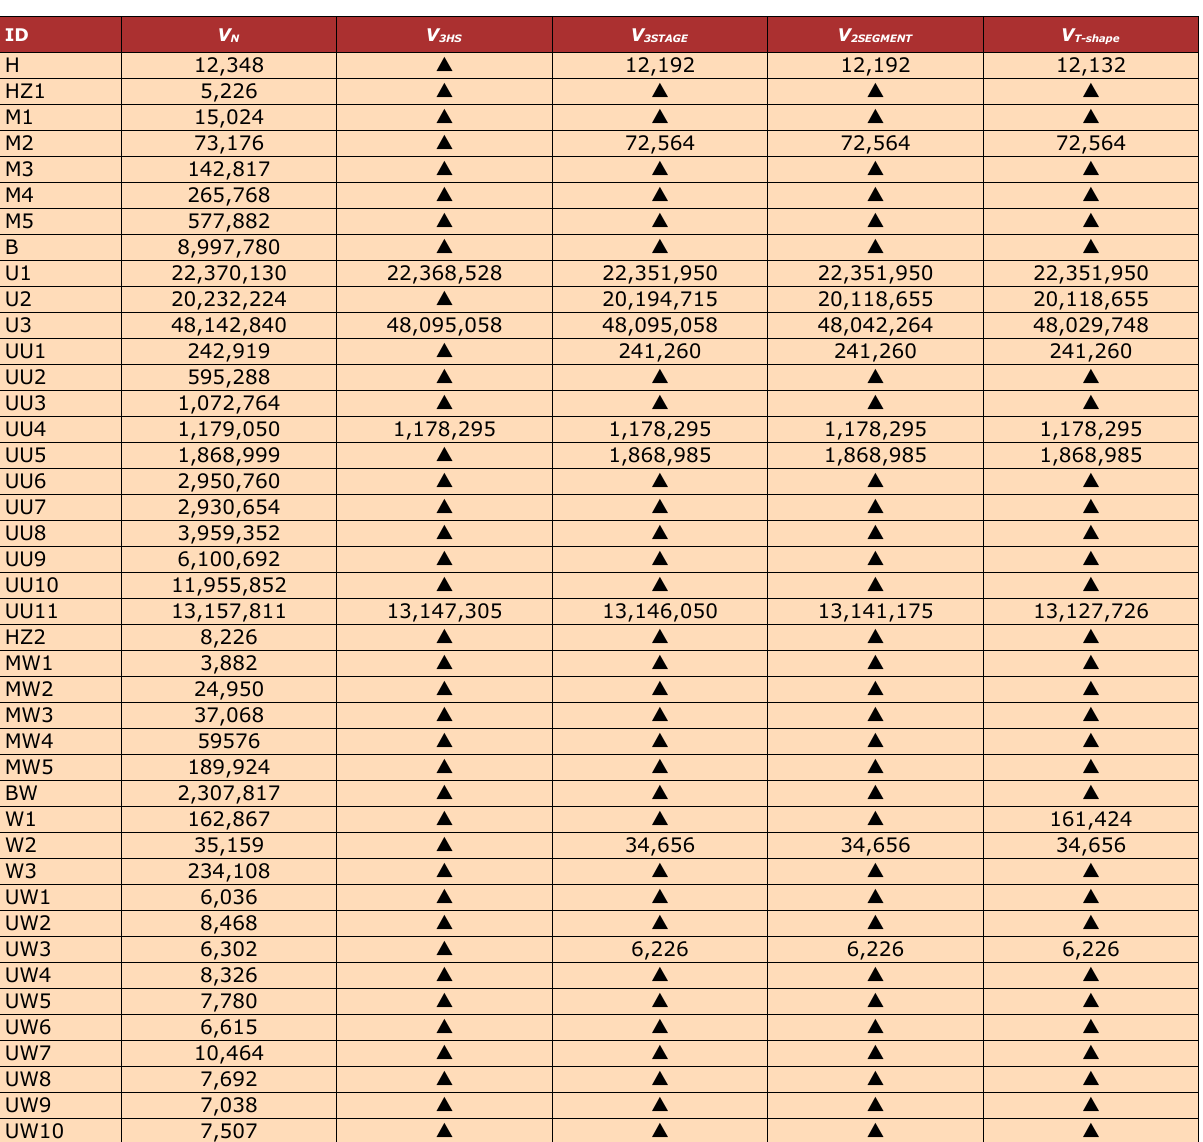
Table 2. The computation results of different layouts